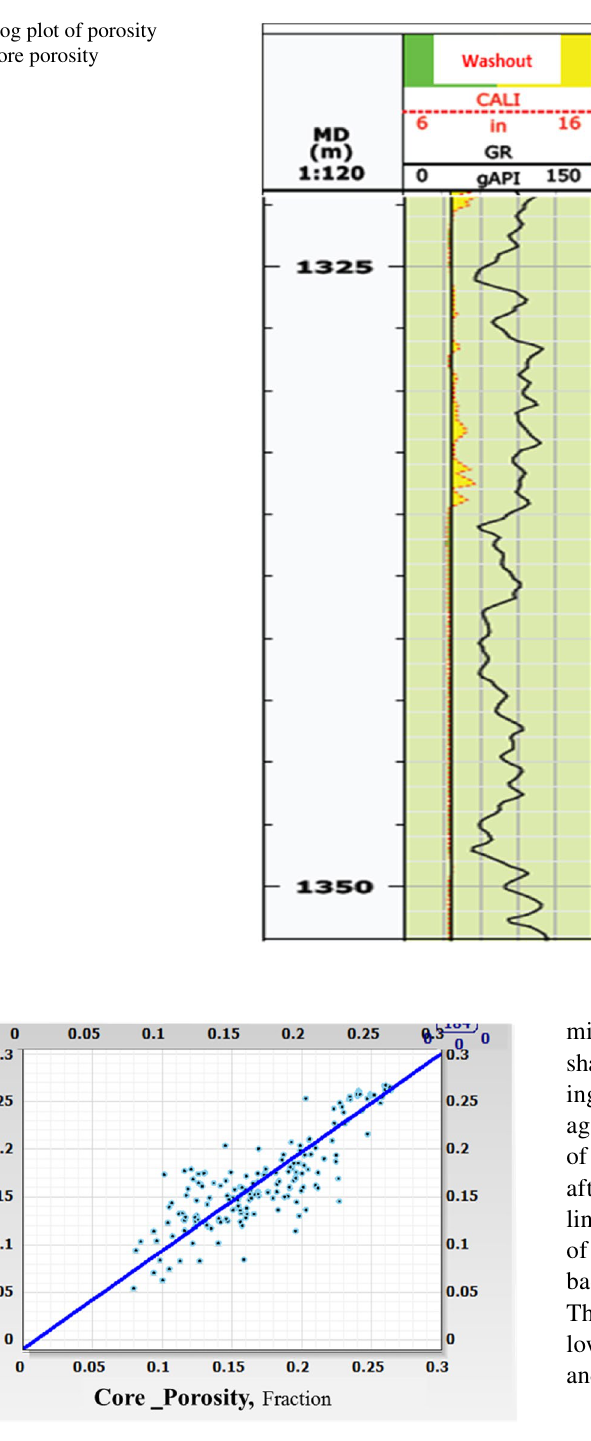
Fig. 8 X , Y plot of log porosity versus core